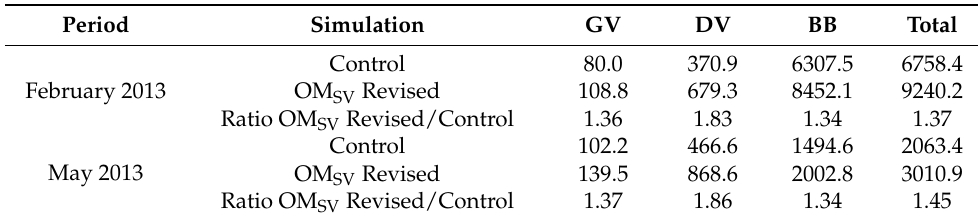
Table 3. Total OM SV emissions (10 3 kg month − 1 ) over the Po Valley computational domain during February and May 2013, and contributions of each source sector (GV: gasoline vehicles; DV: diesel vehicles; BB: biomass burning; and OT: other sources). Control refers to the total emis- sions in SOAP_CNTL, VBS_CNTL, and VBS-NEWIVOC simulation, and OM SV revised in VBS- NEWIVOC+VD